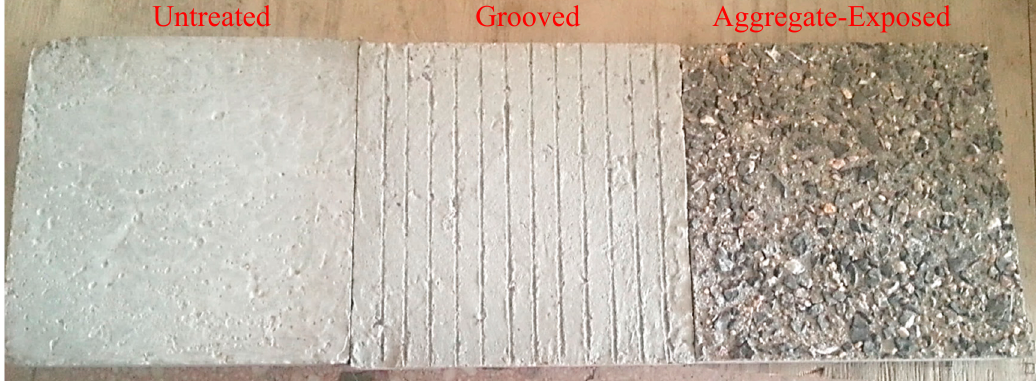
Figure 3. Cement concert slabs with three interface types.